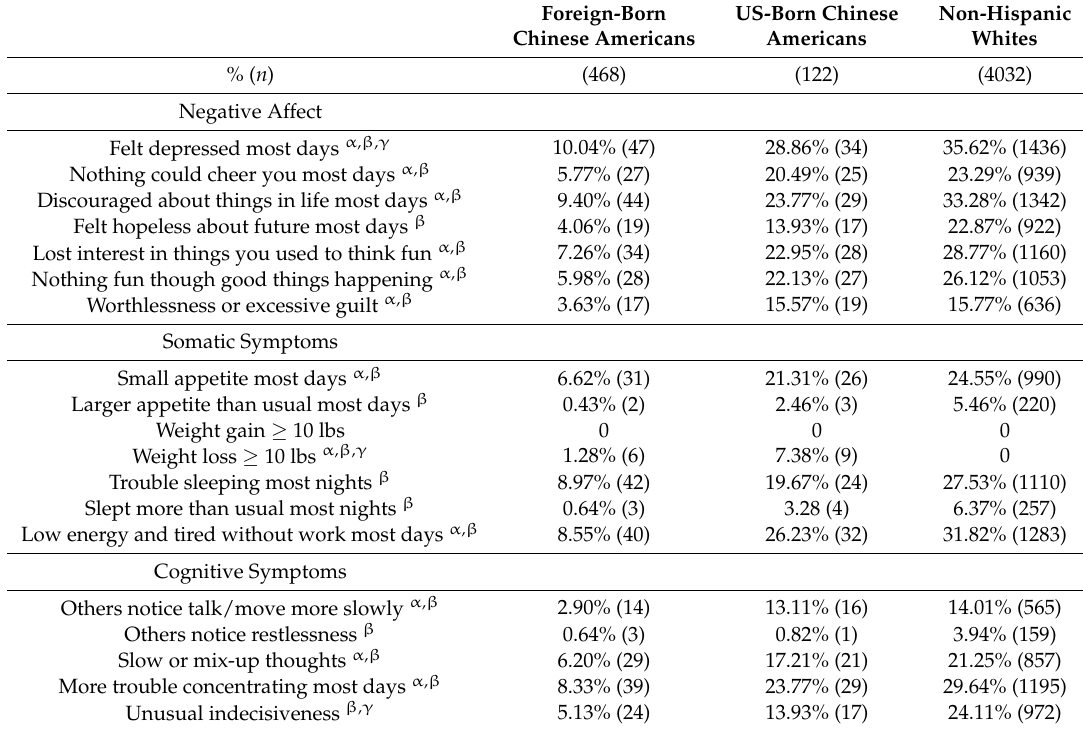
Table 1. Nine Depression Symptoms Measured by Twenty-Four Questions in